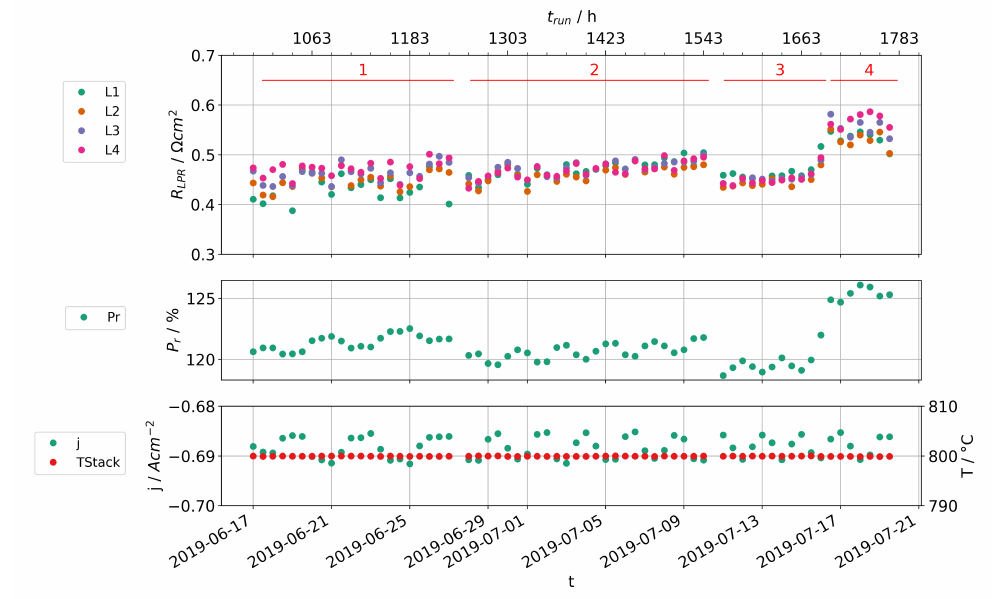
Figure 10. Daily averaged cell resistances by the LPR method for the stationary operation of stack B (top). Averaged relative power (center), current density and stack temperatures (bottom) at the time of the LPR measurements. The operational phases are marked with red